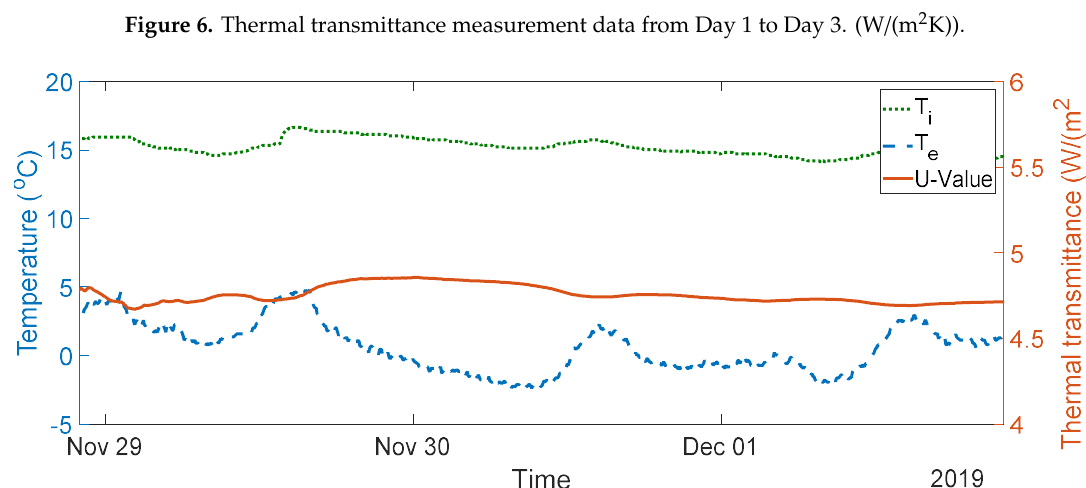
Figure 7. Thermal transmittance measurement data between Day 2 and Day 4.